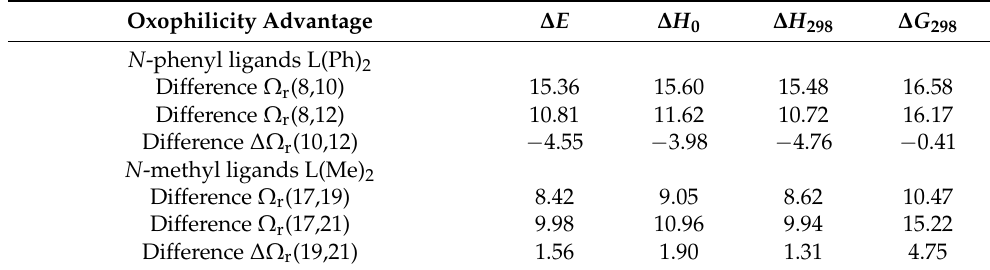
Table 3. Cyclic MAO are much Better Ligands Compared to Acyclic MAO Species (kcal/mol,